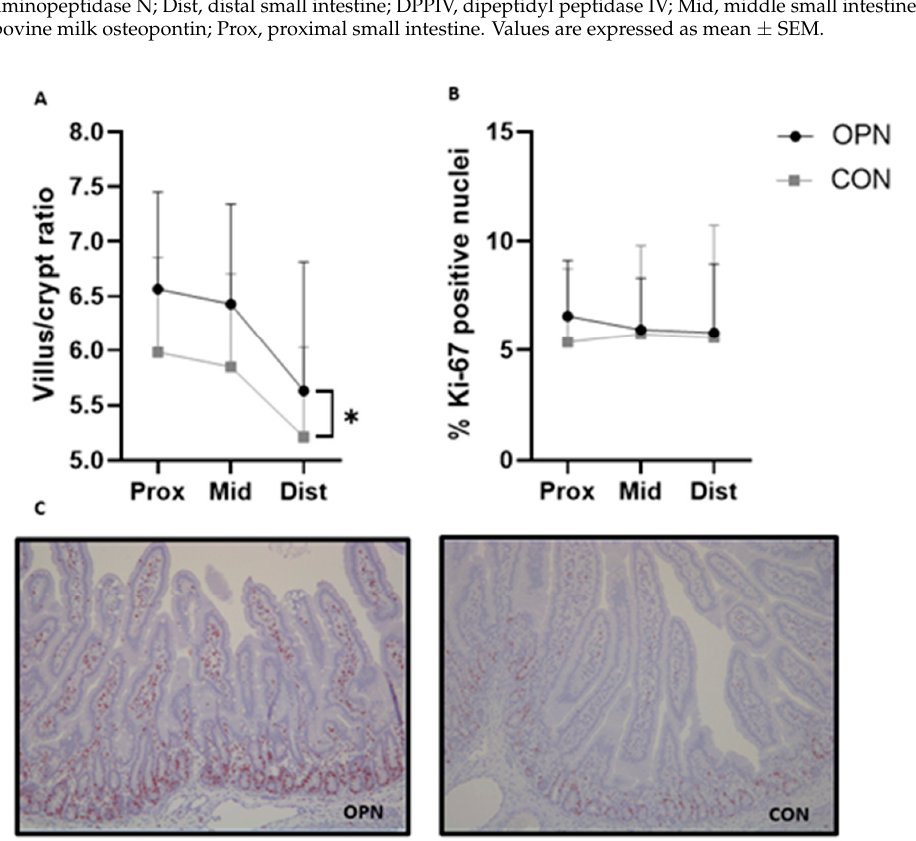
Figure 4. Villus-to-crypt ratio ( A ) and % Ki-67 positive nuclei ( B ) in the small intestine of preterm pigs. The pigs received a bovine milk diet (CON, n = 19) or the milk diet supplemented with bovine milk osteopontin (OPN, n = 16). Immunohistochemical staining for Ki-67 in OPN and CON proximal small intestinal tissue ( C ). Data are expressed as mean ± SD. * p < 0.05. Dist, distal small intestine; Mid, middle small intestine; Prox, proximal small intestine.